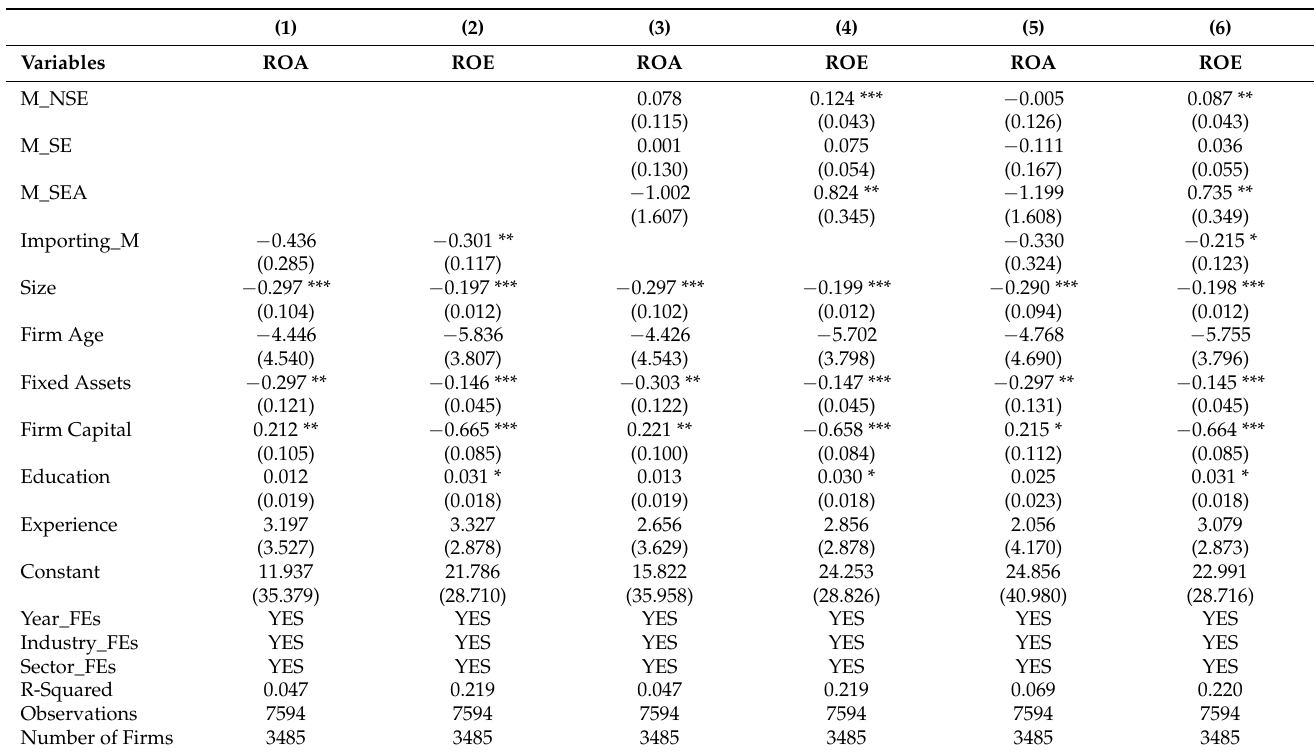
Table 5. Regression